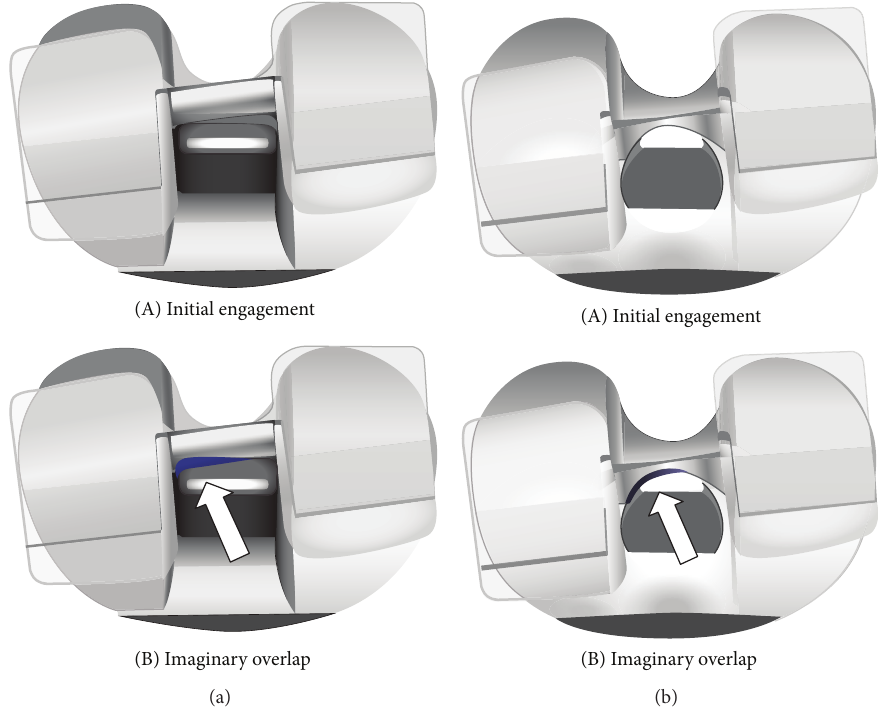
Figure 2: Initial engagement and the imaginary overlap between the tibial post and femoral cam for flat-on-flat (a) and curve-on-curve (b) models